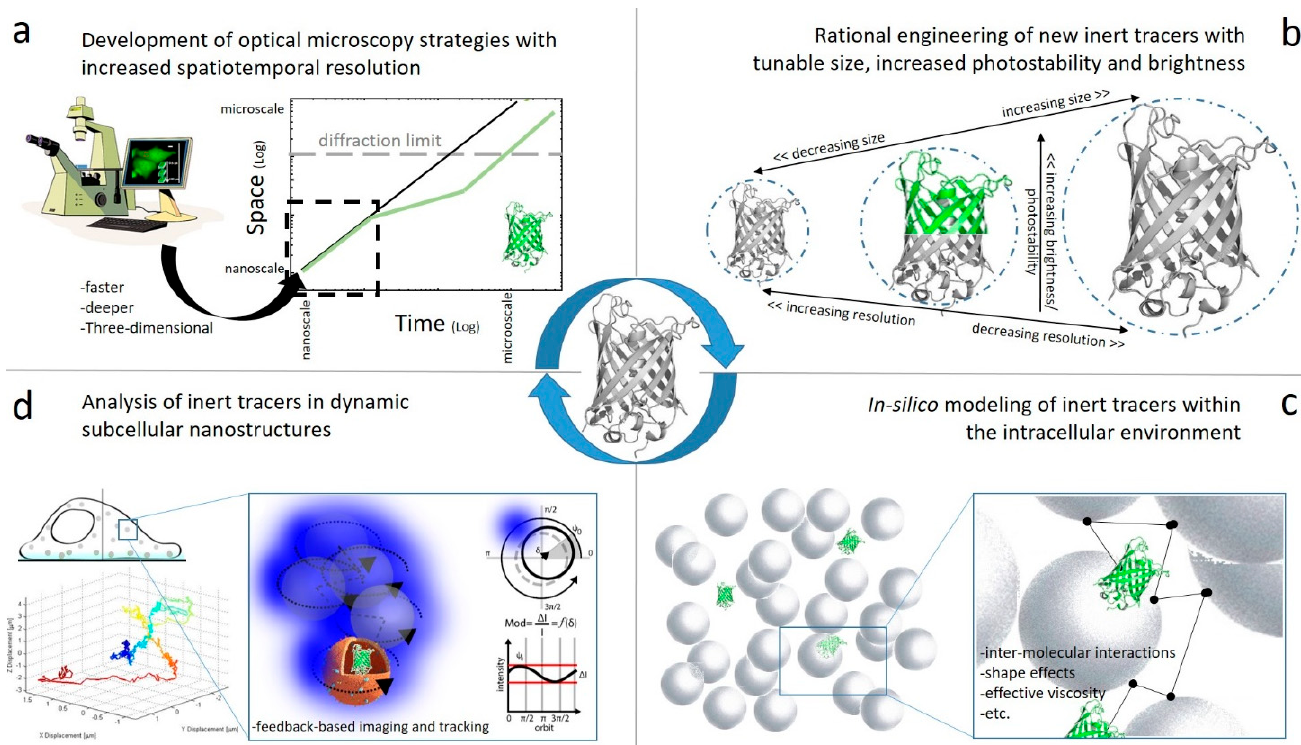
Figure 1. New lines of development concerning the use of genetically encoded FPs as inert tracers of the intracellular environment encompass: ( a ) the development of new fluorescence-based optical microscopy tools with increased spatiotemporal resolution; ( b ) the rational engineering of new inert tracers with tunable size, increased photostability and brightness; ( c ) the e ff ort to model in silico the behavior of inert tracers within the intracellular environment; ( d ) the use of new strategies to grab the behavior of inert tracers in dynamic subcellular nanosystems, such as organelles, transport vesicles, cellular protrusions,